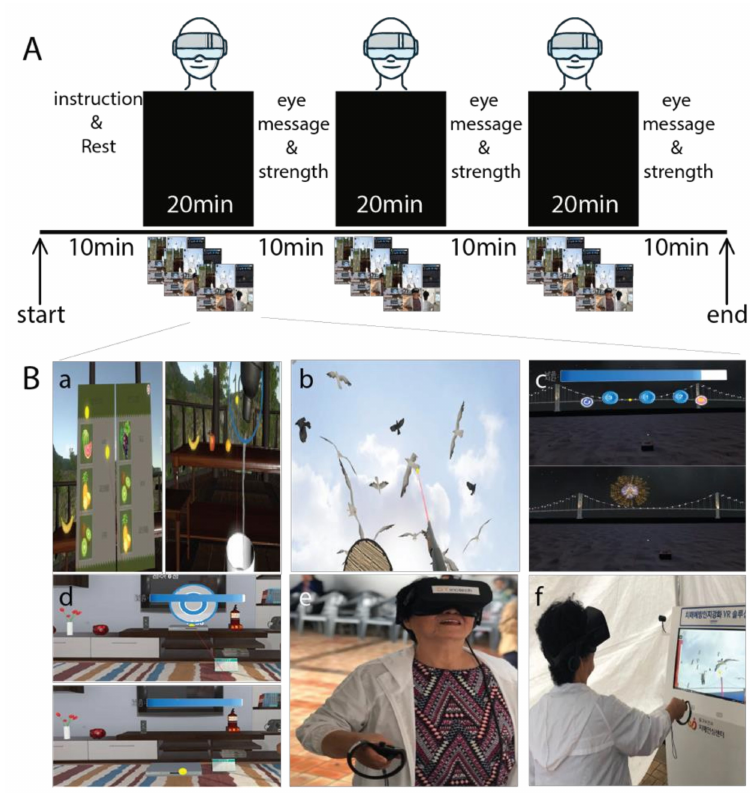
Figure 2. ( A ) This figure illustrates the design for the virtual reality (VR) training design and game contents. The total training duration was 100 minutes (three 20 min VR training sessions, and three 10 min eye massage and stretching sessions) held three times a week for 8 weeks. ( B ) The contents of the VR training games: (a) juice making, (b) crow shooting, (c) find the fireworks number, (d) memory object at the house, (e) and (f) example of